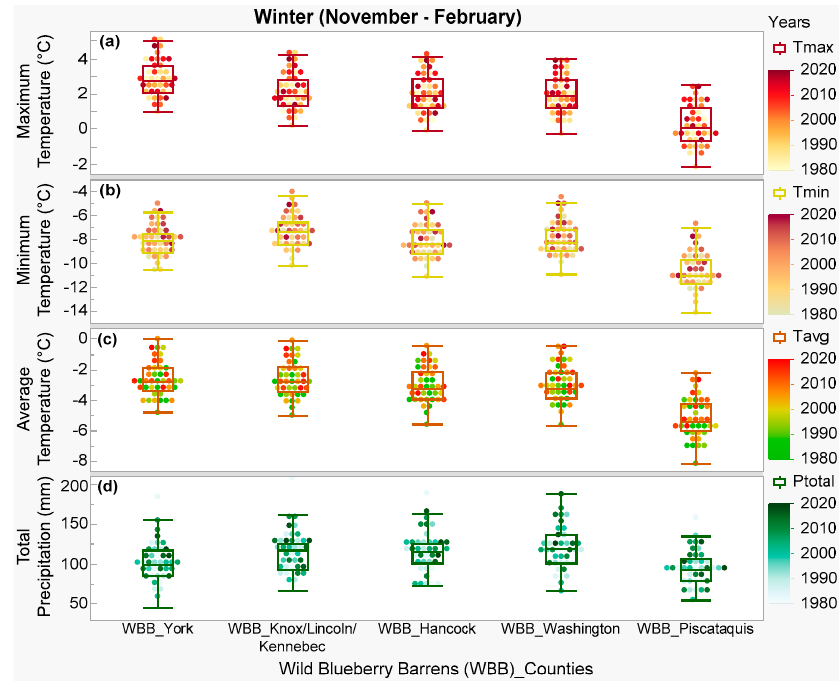
Figure 6. Comparison of historical (1980 to 2020) winter climate parameters: ( a ) maximum temperature, ( b ) minimum temperature, ( c ) average temperature, and ( d ) total precipitation among the studied wild blueberry barrens (WBBs) in different counties from north-central (Piscataquis) and north-east (Washington, Hancock) to south-west (Knox, Lincoln, Kennebec, York) of Maine as shown in Figure 1.